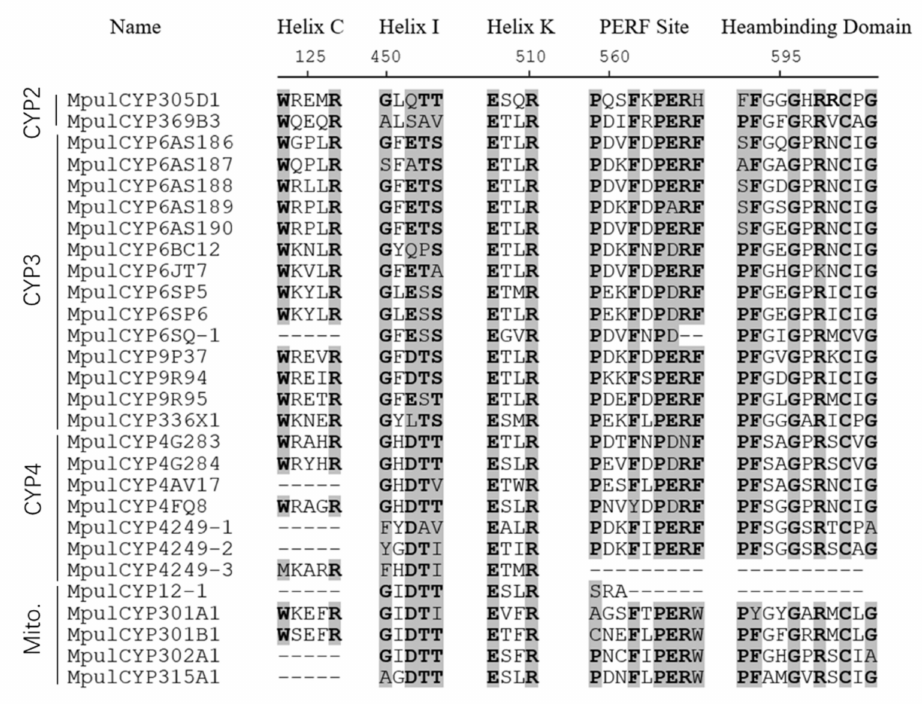
Figure 1. Alignment of functional domains of the 28 MpulCYPs . Conserved motifs are indicated in